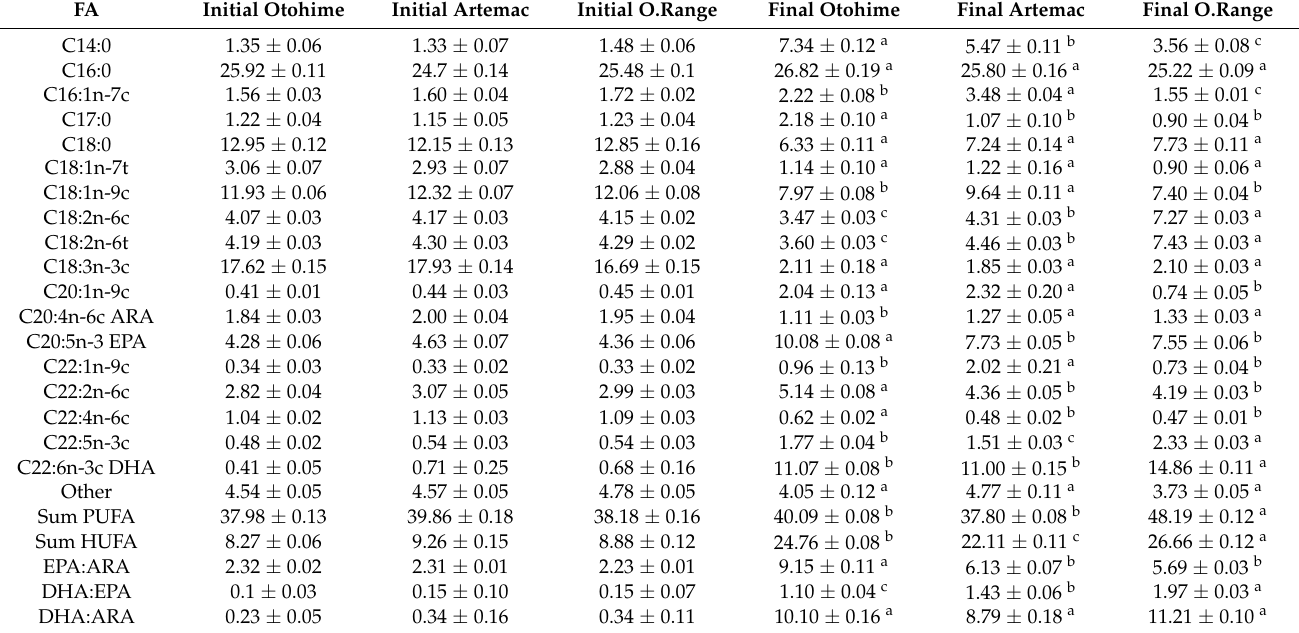
Table 3. Mean initial and final percent fatty acid composition ( ± SE) of larval giant k¯okopu for three feed treatments. Only fatty acids that are present at >1% are included, “Other” is the sum of all